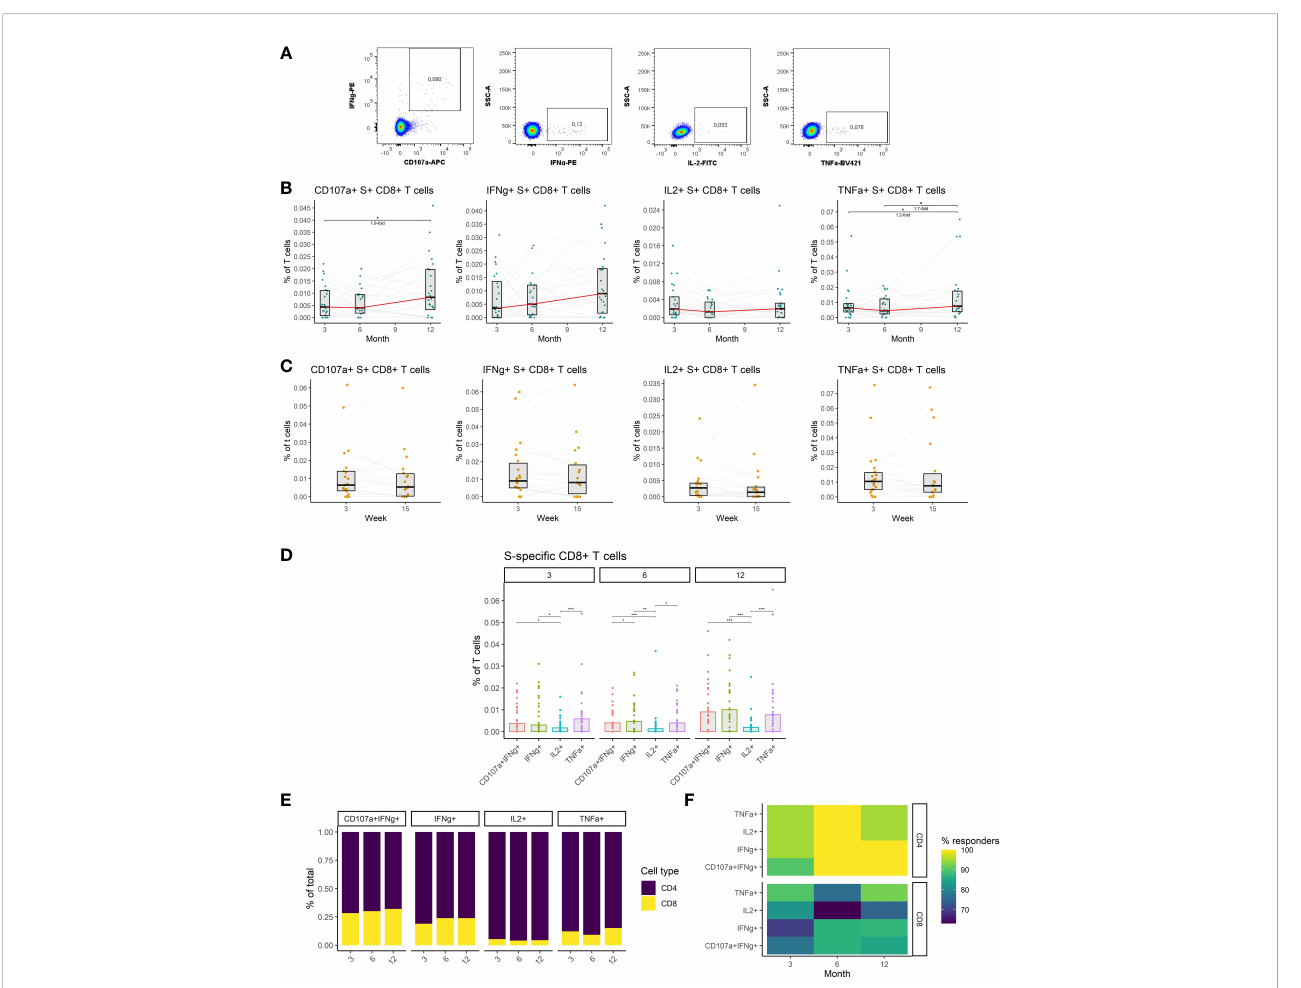
FIGURE 5 The dynamics of SARS-CoV-2-speci fi c CD8+ T cells after the initial and booster doses of mRNA vaccine. (A) Representative fl ow cytometry plots demonstrating the detection of S-speci fi c CD8+ T cells with different effector functions; cytotoxicity (CD107a and IFN g expression), IFN g expression, IL-2 expression, and TNF a expression. (B) The frequencies of S-speci fi c CD8+ T cells with different effector functions as a percentage of bulk T cells for months 3, 6, and 12 after the initial vaccination. The red line connects the median values of each time point. Fold change was calculated as a ratio of the medians of compared time points. (C) The frequencies of S-speci fi c CD8+ T cells with different effector functions in the peripheral blood of vaccinated individuals 3 to 15 weeks after the booster vaccination. (D) Comparison of S-speci fi c CD8+ T cell frequencies with different functions for months 3, 6, and 12 after the initial vaccination. (E) Relative proportions of CD4+ and CD8+ S-speci fi c T cells with different effector functions for months 3, 6, and 12 after the initial vaccination. (F) Percentage of individuals with detectable S1-speci fi c CD4+ or CD8+ T cells according to the effector function and time point. Differences between the groups were assessed using the Wilcoxon test with Holm ’ s correction for multiple testing. *p < 0.05, **p < 0.01, ***p < 0.001, ****p <